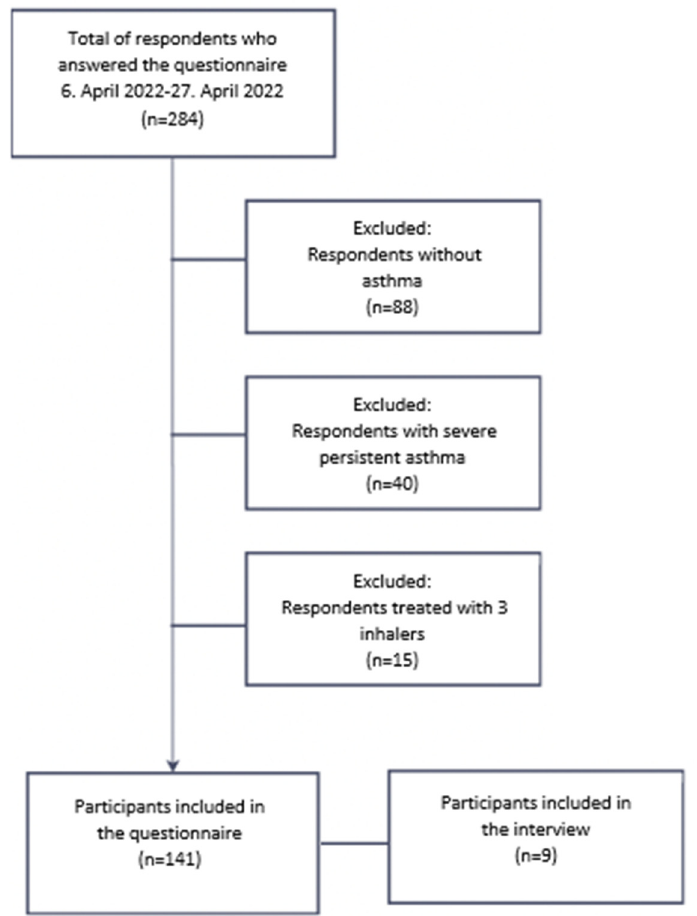
Figure 1. The inclusion and exclusion process is outlined in a flow diagram.